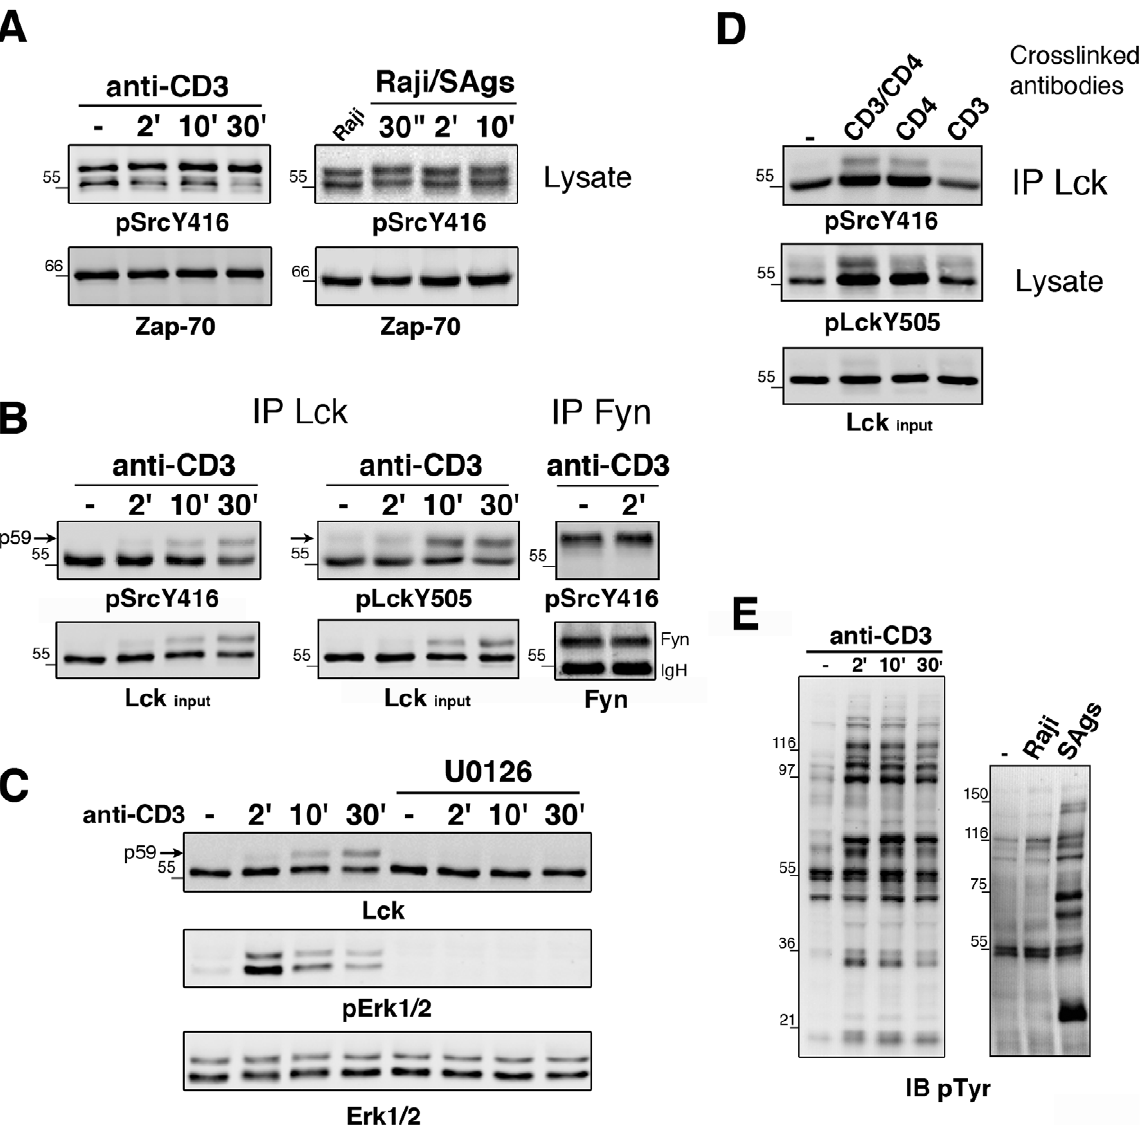
Figure 1. Lck and Fyn phosphorylation state in primary T cells. (A) Naı¨ve CD4 + CD45RA + T cells were stimulated with anti-CD3, superantigen- pulsed APCs (Raji/SAgs) for the indicated times. Cell lysates were immunoblotted with anti-pSrcY416 and, to control protein loading, with anti-Zap- 70. (B) Lck and Fyn immunoprecipitates (IP) from anti-CD3 stimulated cells were immunoblotted with anti-pSrcY416. Phosphorylation of Lck inhibitory Tyr505 was analyzed on separate IP. Lck input corresponds to 10 m g proteins. (C) Immunoblot analysis of Lck IPs, phosphorylated Erk-1/2 and Erk-1/2 in cell lysates of naı¨ve CD4 + T cells preincubated or not with U0126 and stimulated with anti-CD3 (one donor used in B). (D) Naı¨ve CD4 + T cells were stimulated by crosslinking the indicated antibodies for 30 sec. Lck IPs and cell lysates were immunoblotted with anti-pSrcY416 and anti- pLckY505, respectively. (E) Tyrosine phosphorylations induced by anti-CD3 and Raji/SAgs (2 min) stimulation after immunoblotting cell lysates with anti-phosphotyrosine antibodies. These assays were performed with 9